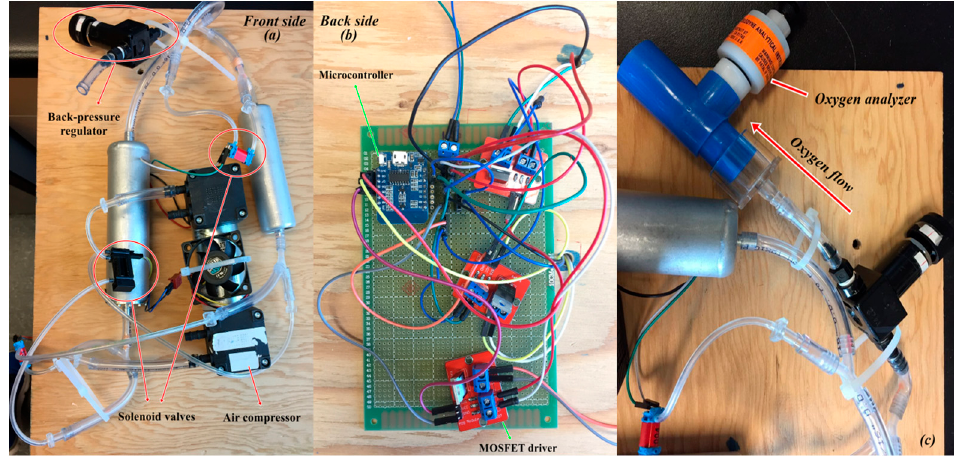
Figure 10. Photograph of oxygen concentrator prototype ( a ) front side, ( b ) back side, ( c ) Oxygen analyzer.